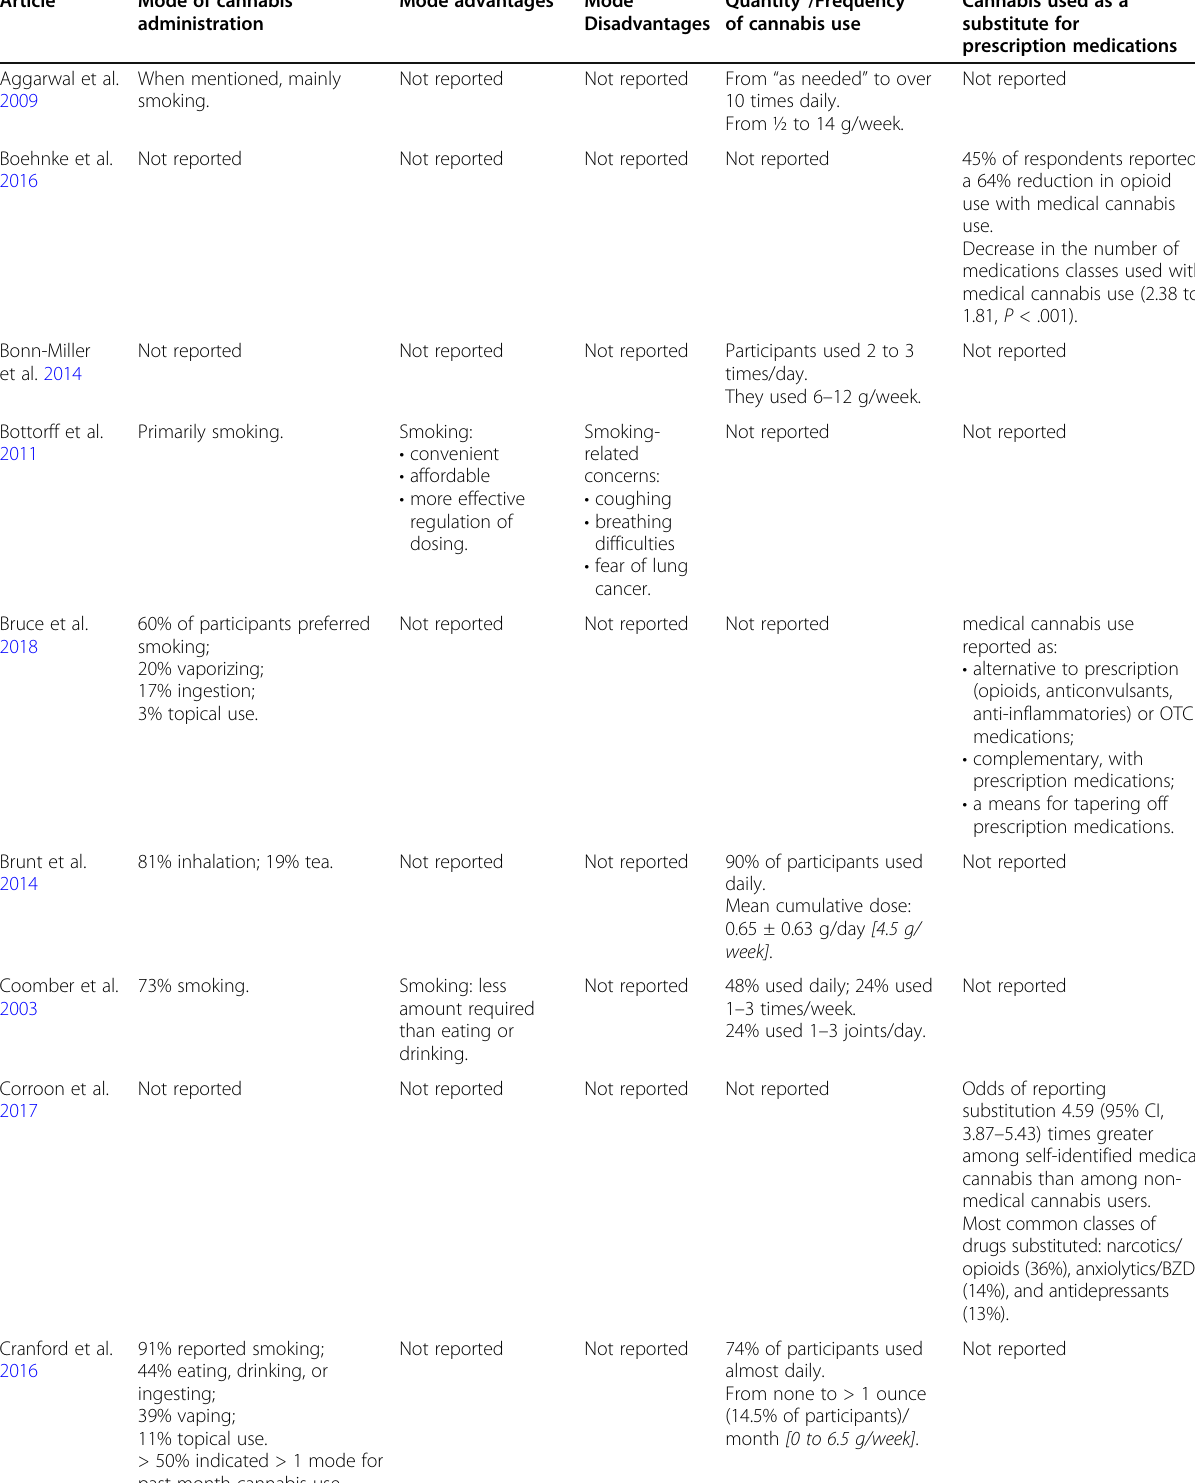
Table 2 Patterns of medical cannabis use and utilization of medical cannabis as a substitute for prescription